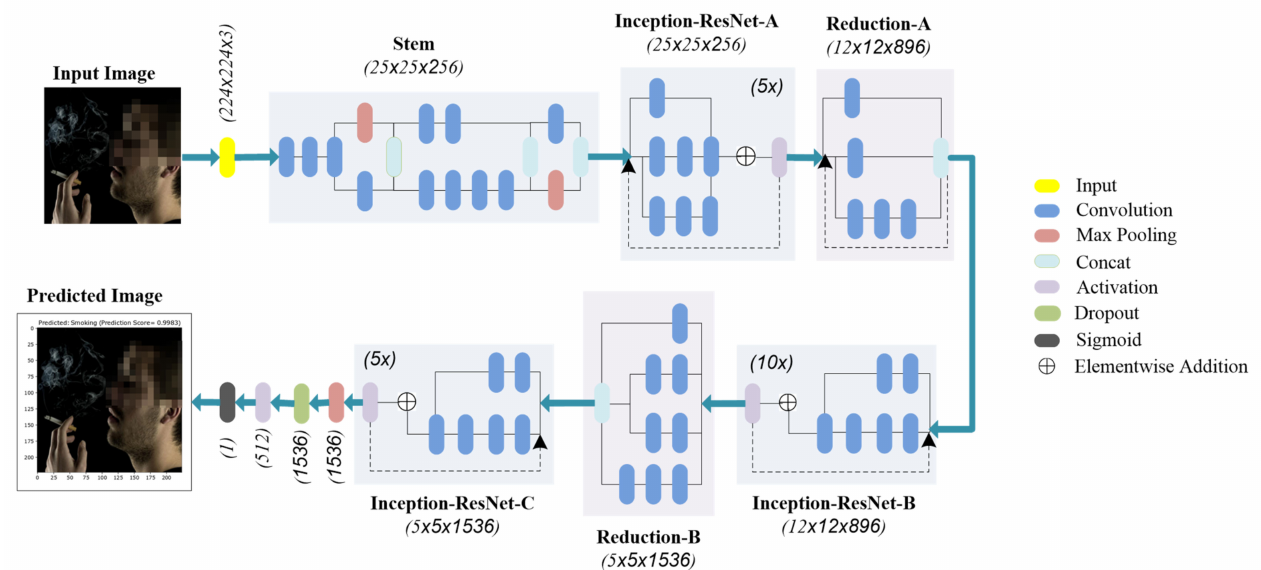
Figure 3. Inception-ResNet-V2 model for smoker